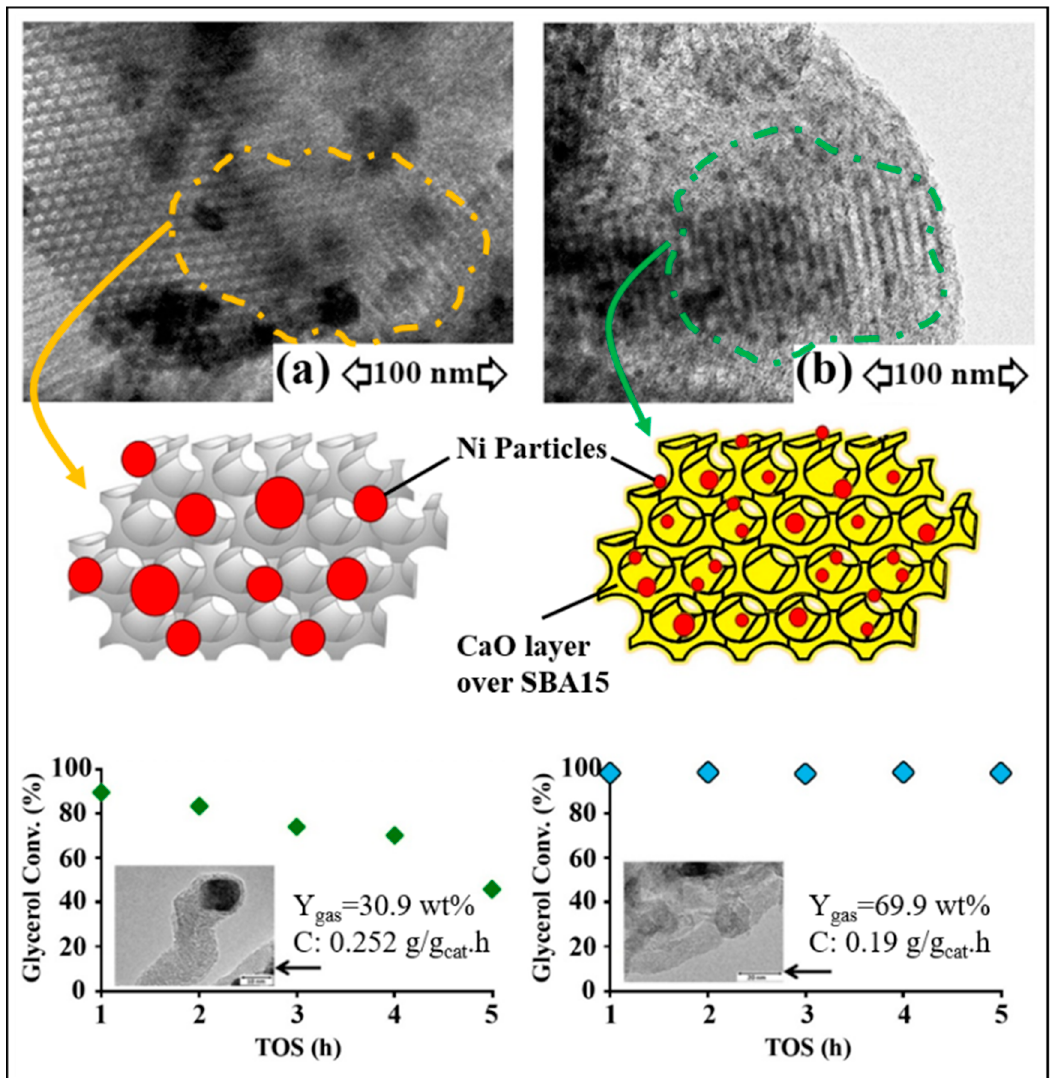
Figure 7. Glycerol conversion using Ni catalysts supported on SBA15 promoted with Ca [81] (redrawn Figure 7. The catalytic glycerol conversion over ( a ) Ni / SBA-15, and ( b ) Ni / Ca / SBA-15 catalysts; the e ff ect with copyright permission). of Ni particle size [81] (redrawn with copyright